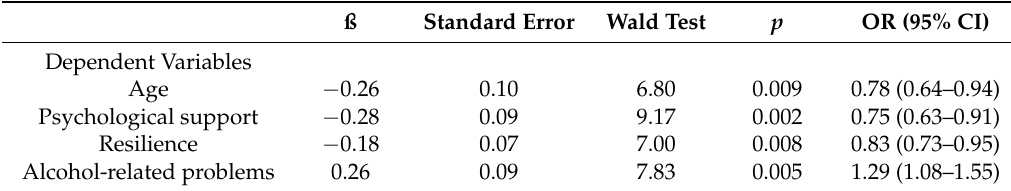
Table 4. Risk and protective factors identified in the stepwise logistic regression model.